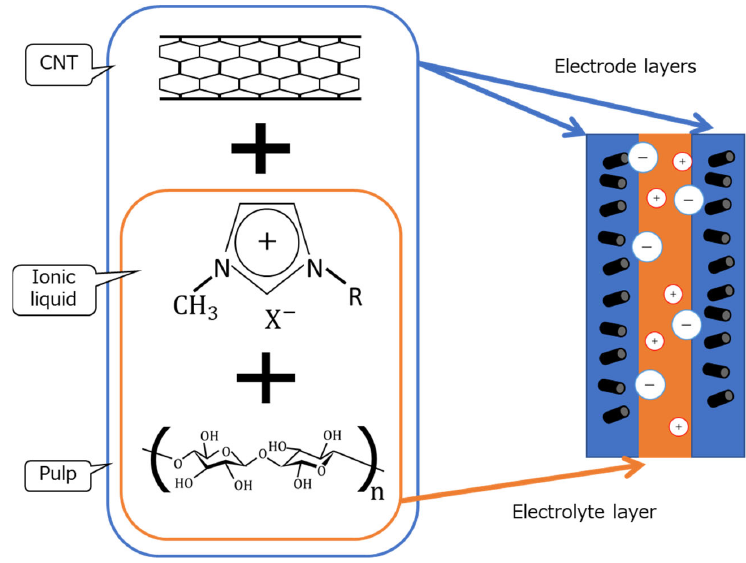
Molecules 2021 , 26 , x FOR PEER REVIEW Figure 1. Structure of CNT ‐ composite paper actuator. Figure 1. Structure of CNT-composite paper actuator.